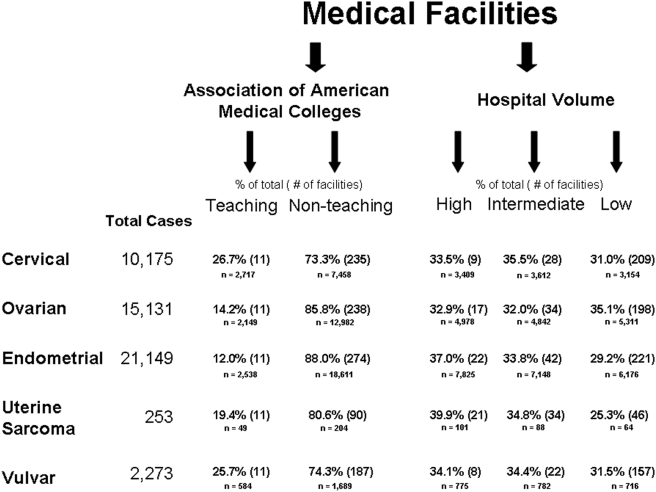
Flow diagram depicting number of incident gynecologic malignancies diagnosed in the state of Florida from 1990–2000.